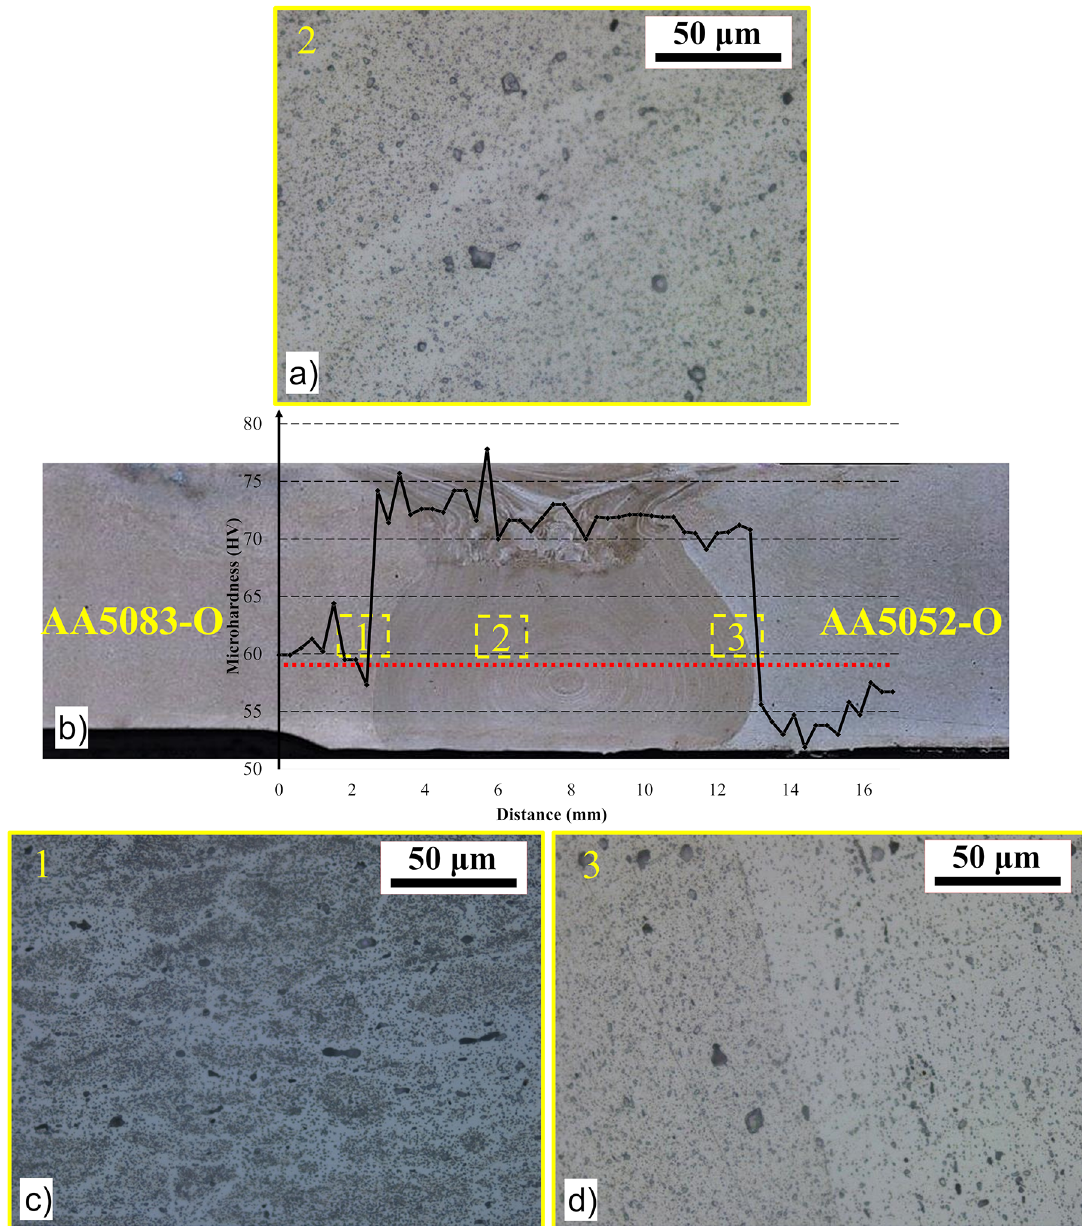
Figure 8. Weld G4: (a) stir zone, (b) macrostructure and microhardness - red line represents Vickers measurements, (c) AA5083-O interface, and (d) AA5052-O